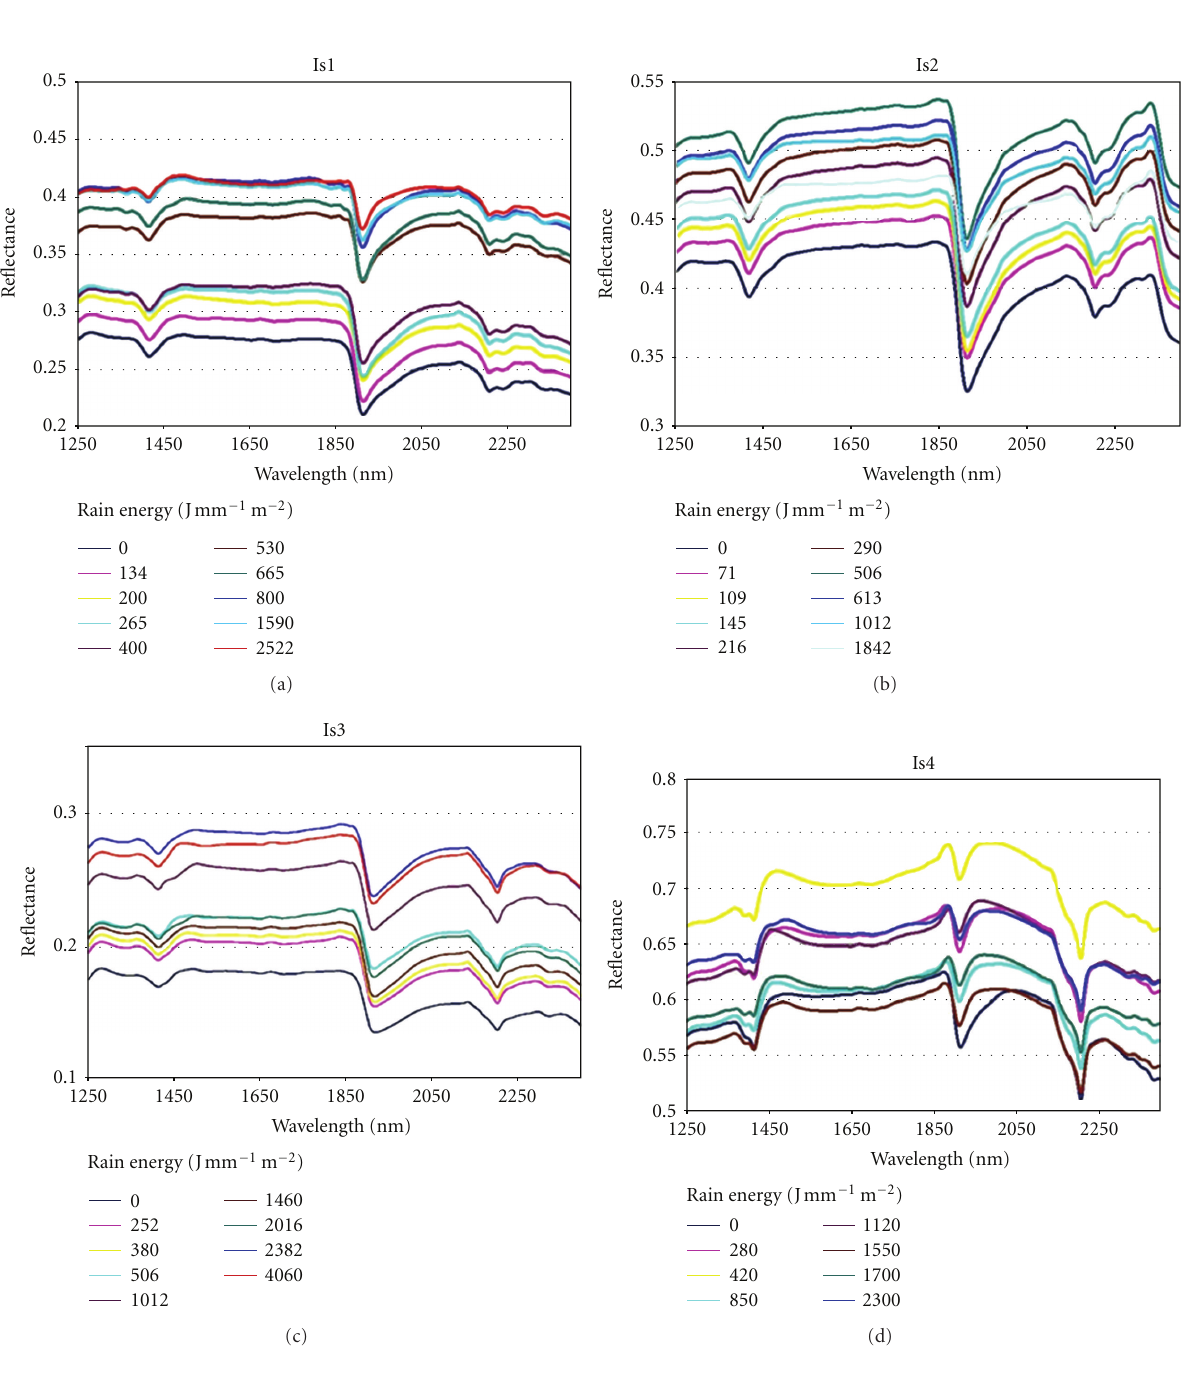
Figure 1: Spectral reflectance of each cumulative (rain) energy level for Israeli soil